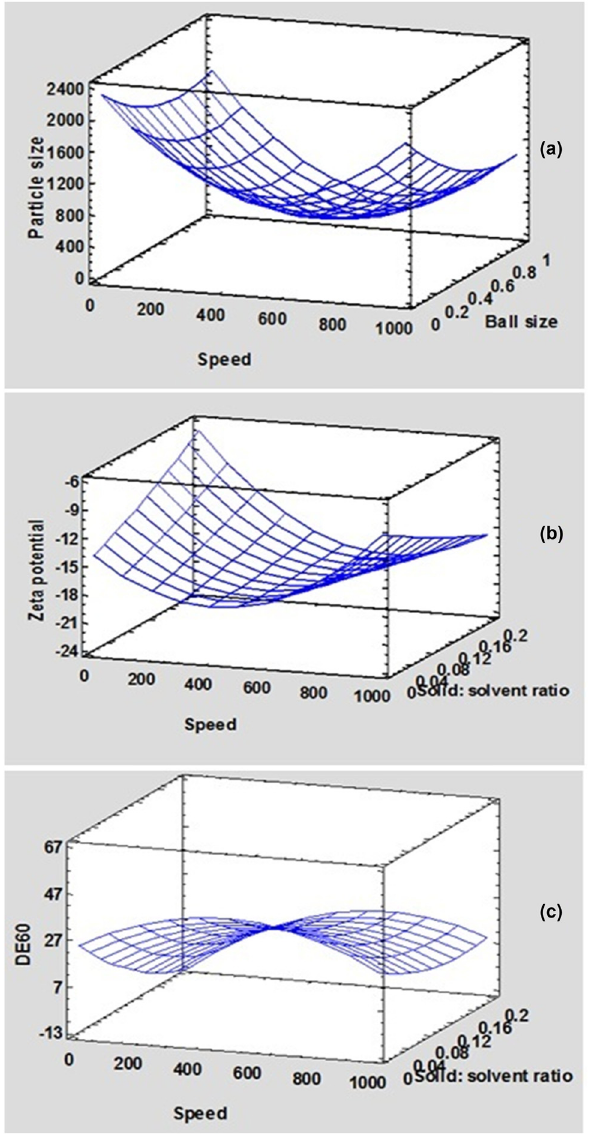
Figure 1: Response surface plot for the e ff ect of milling speed and solid/solvent ratio on APG nanoparticle size ( a ) , zeta potential ( b ) , and % DE 60 ( c ) ( ball size was kept constant at medium level )